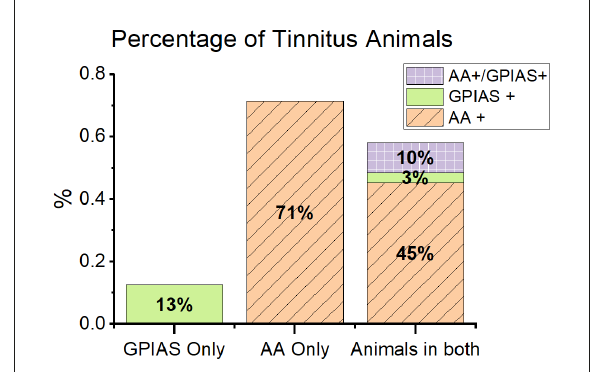
FIGURE3 Animals showed different patterns of behavior in GPIAS and AA. Animals in the study are separated by training paradigm. GPIAS only = animals only trained in GPIAS (green). AA only = animals only trained in AA (orange with diagonal lines). Animals in both = all animals trained in both AA and GPIAS (purple with boxes). Overall, animals were more likely to be positive in AA than GPIAS. Very few animals were positive in both tests. Most of the animals positive in GPIAS were also positive in AA, very few were positive in GPIAS alone. Active avoidance training first increased the incidence of AA positive animals. N values: Only GPIAS n = 9, Only AA n = 7, AA with GPIAS post n =